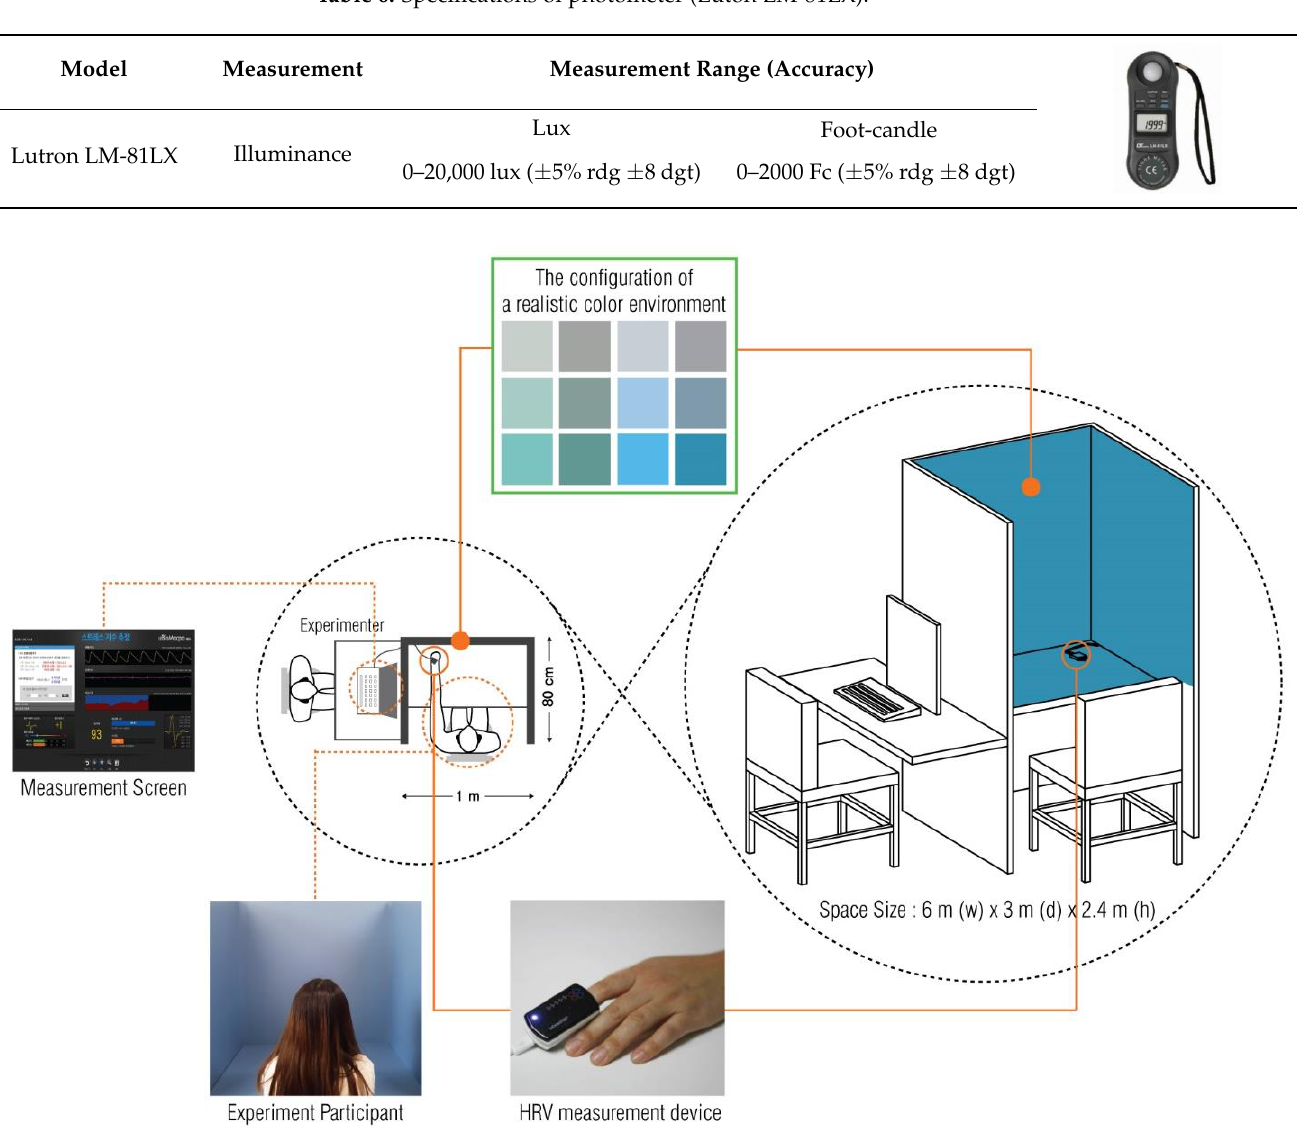
Figure 3. HRV measurement